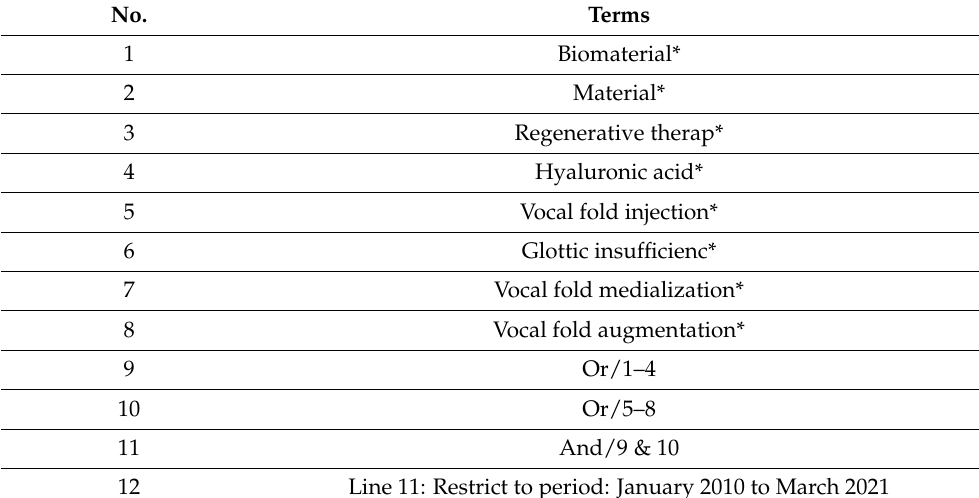
Table 1. Search strategy for all databases. (*: to obtain both singular and plural forms of the search